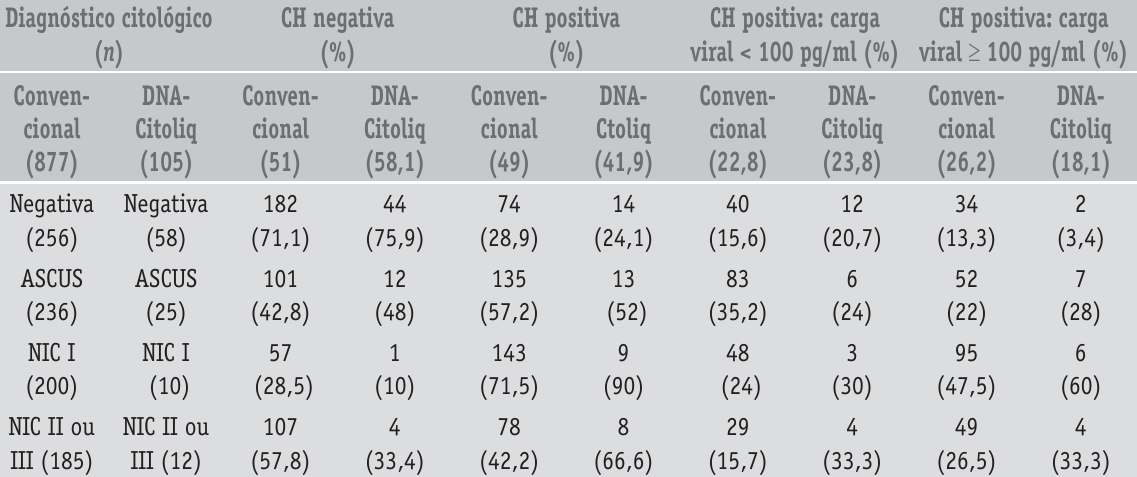
ASCUS: células escamosas atípicas de signifi cado indeterminado; CH: captura híbrida; NIC: neoplasia intra-epitelial cervical.